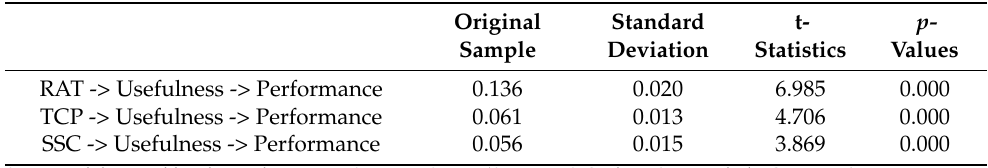
Table 6. Specific indirect